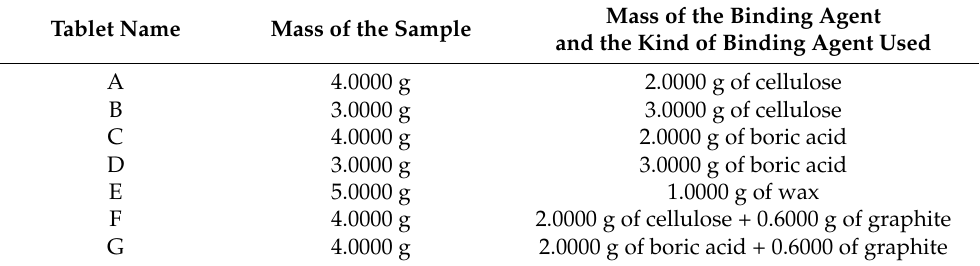
Table 5. Compositions of tablets